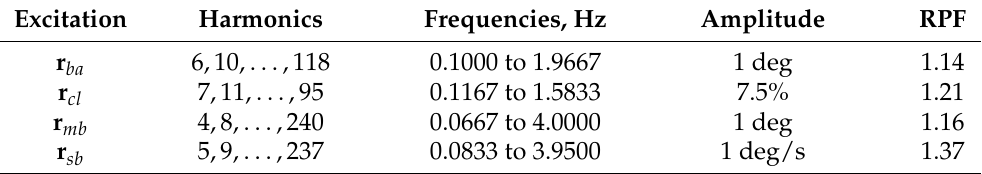
Table 5. A summary of multisine design parameters for the X-59 example ( T = 60